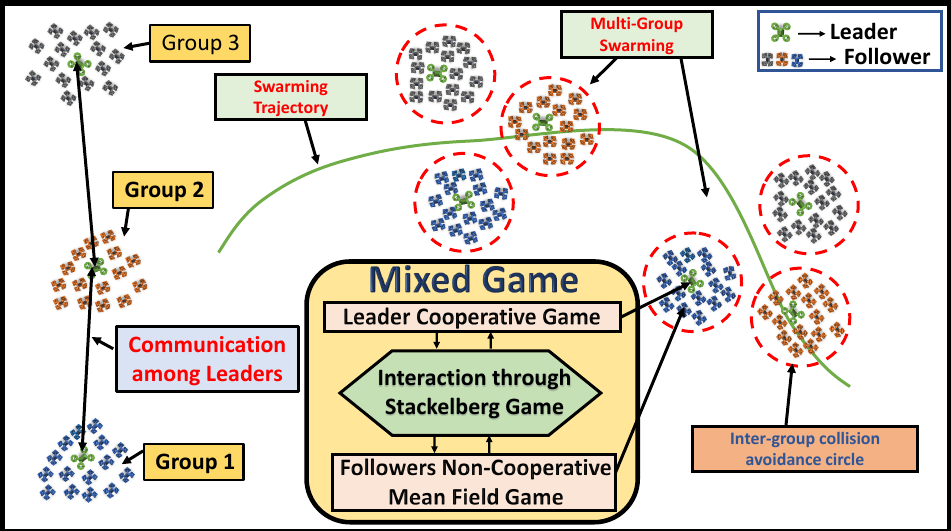
Figure 1. An illustration of mixed game-based leader–follower multi-group